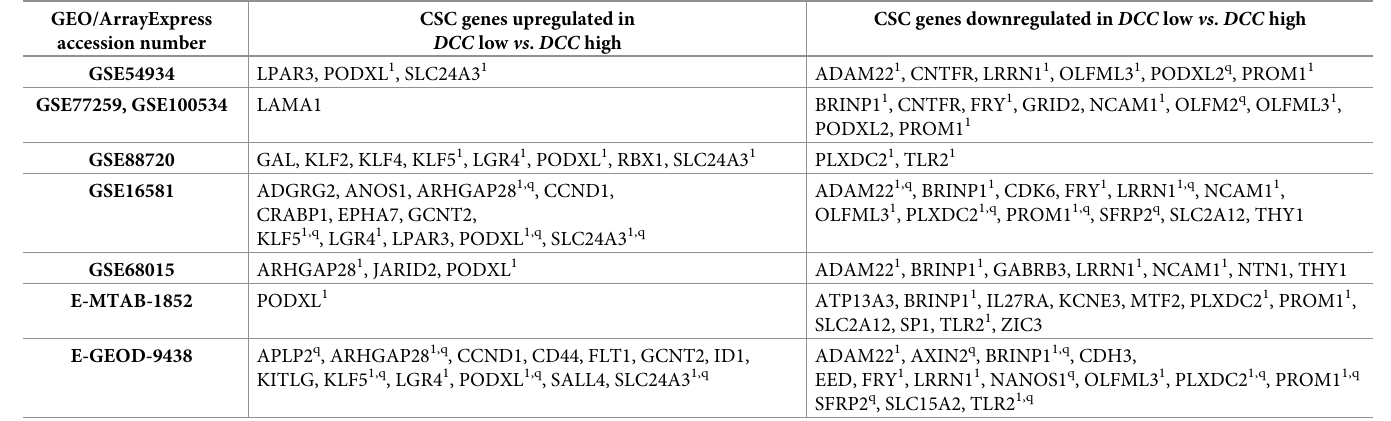
Table 2. CSC genes significantly deregulated in DCC low vs . DCC high expression